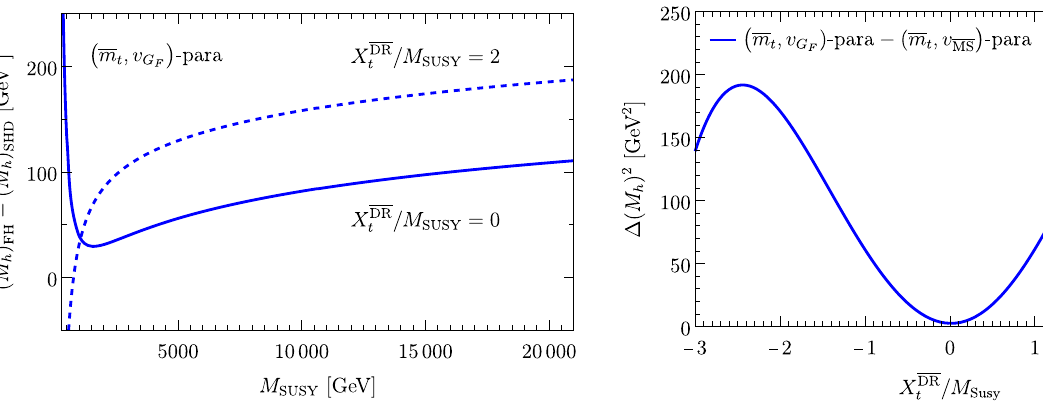
Fig. 4 Left: Difference of the M 2 predictions of FeynHiggsnew the top-quark mass and the vev in a fixed-order O (α t α s ,α 2 t ) calcula- h tion, taking into account only non-logarithmic terms, as a function of DR and SUSYHD as a function of M SUSY for X DR t / M SUSY = 0 (solid) X DR t / M SUSY . The difference between the result parametrized in terms and X DR t / M SUSY = 2 (dashed). For the parametrization of the dia- of the MS NNLO top-quark mass and v G and the one parametrized in grammatic result of FeynHiggs the SM NNLO MS top-quark mass F terms of the MS NNLO top-quark mass and v is is chosen. Right: Differences due to the different parametrization of MS